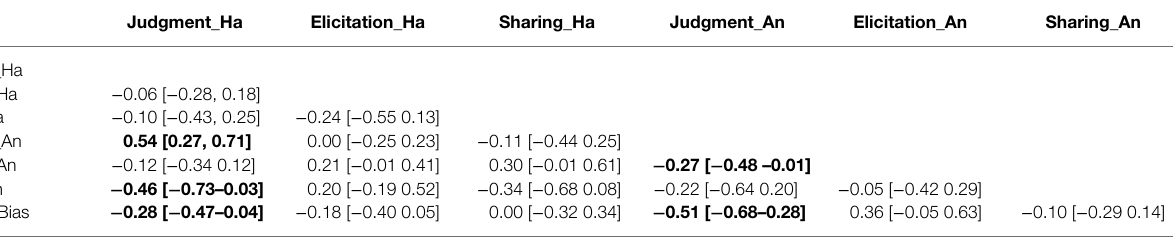
TABLE 4 | Correlation among all parameters.